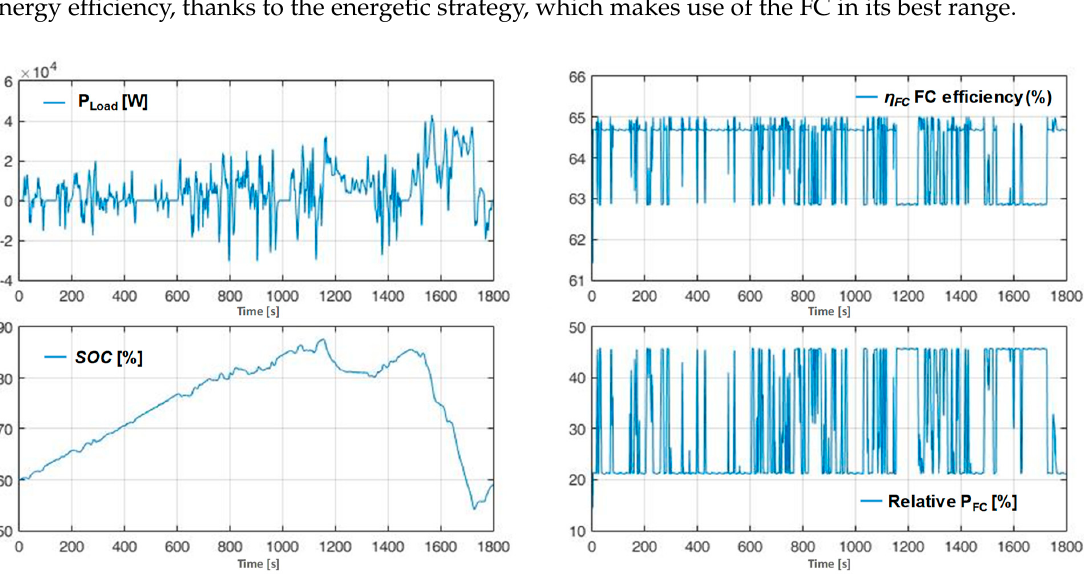
Figure 12. Testing of the optimized system on the WLTC standard cycle.